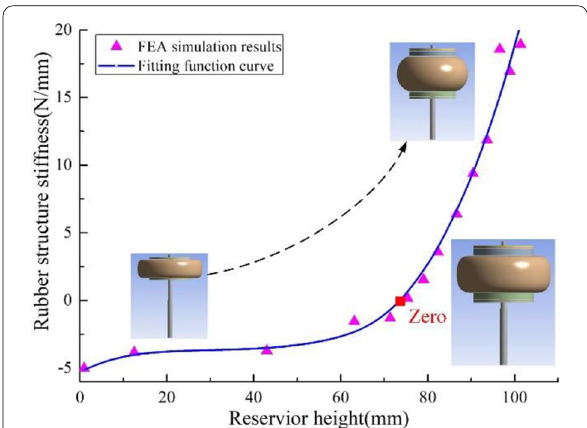
Figure 6 Rubber structural stiffness Table 2 The stiffness fitting function and